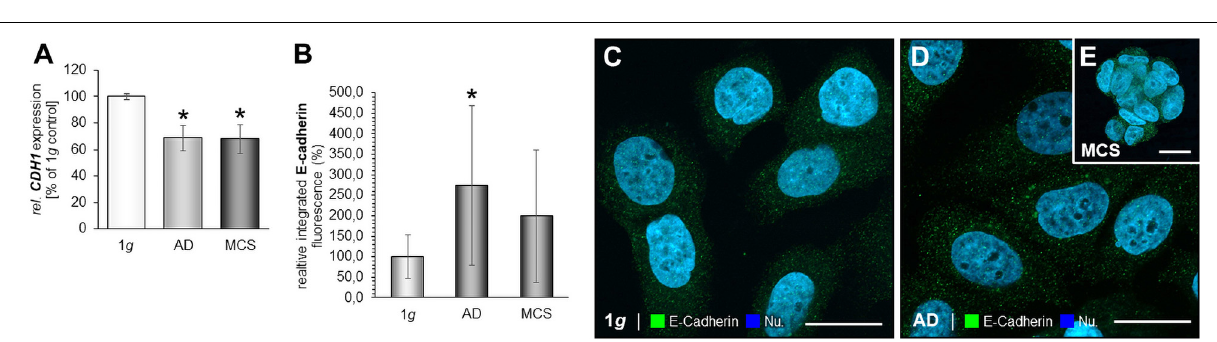
FIGURE 6 | E-cadherin in microgravity-exposed MCF-7 BCC. (A) CDH1 gene expression in MCF-7 BCC exposed to s- µ g . (B) Analysis of the fluorescence intensity of E-cadherin (C) , IFS of E-cadherin of 1 g MCF-7 BCC RPM-exposed BCC [AD: (D), MCS: (E) ]. * p < 0.05 1 g vs. AD and/or